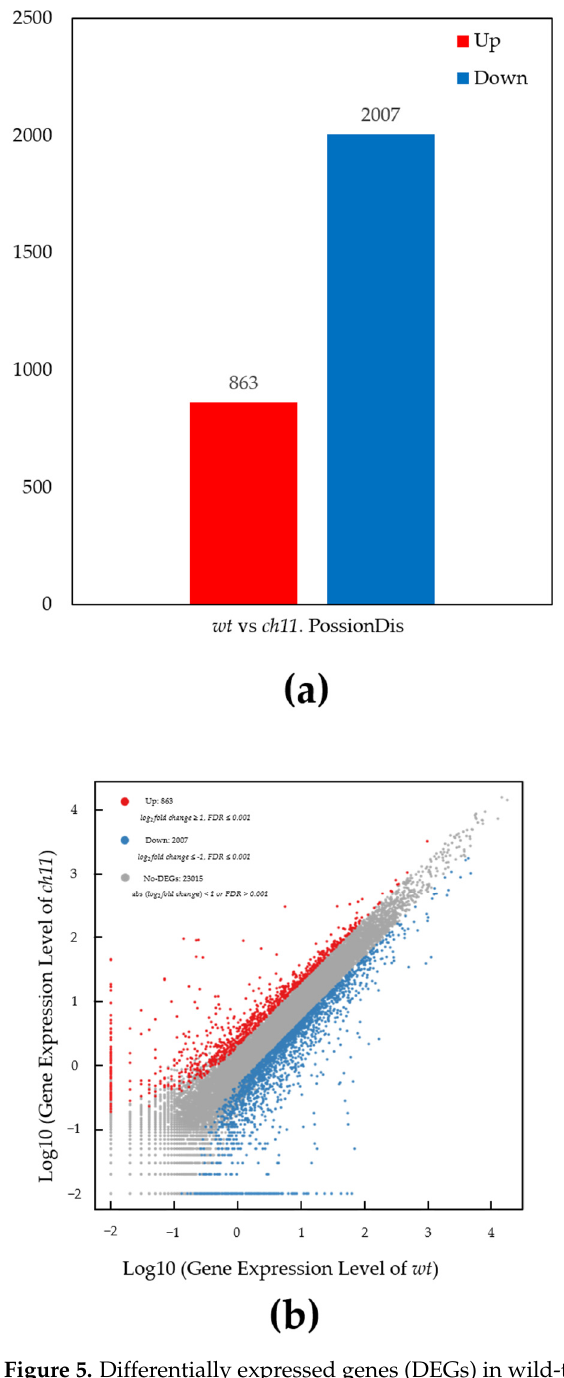
Figure 5. Differentially expressed genes (DEGs) in wild-type ( wt ) and chlorophyll b -deficient ( ch11 ) rice. ( a ) Comparison of up- and down-regulated DEGs; ( b ) Classification of genes, based on differences in expression level.